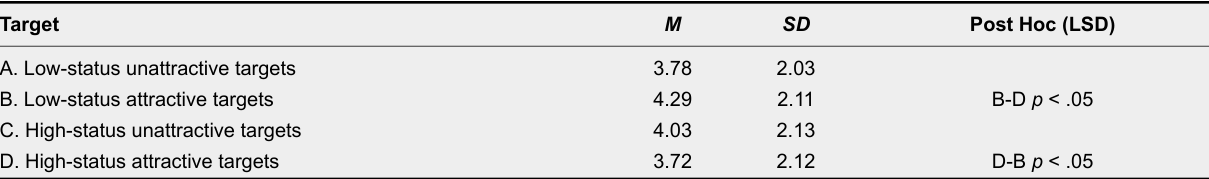
Perceived Openness: Simple-Effects Comparisons for the Interaction of Status and Attractiveness.